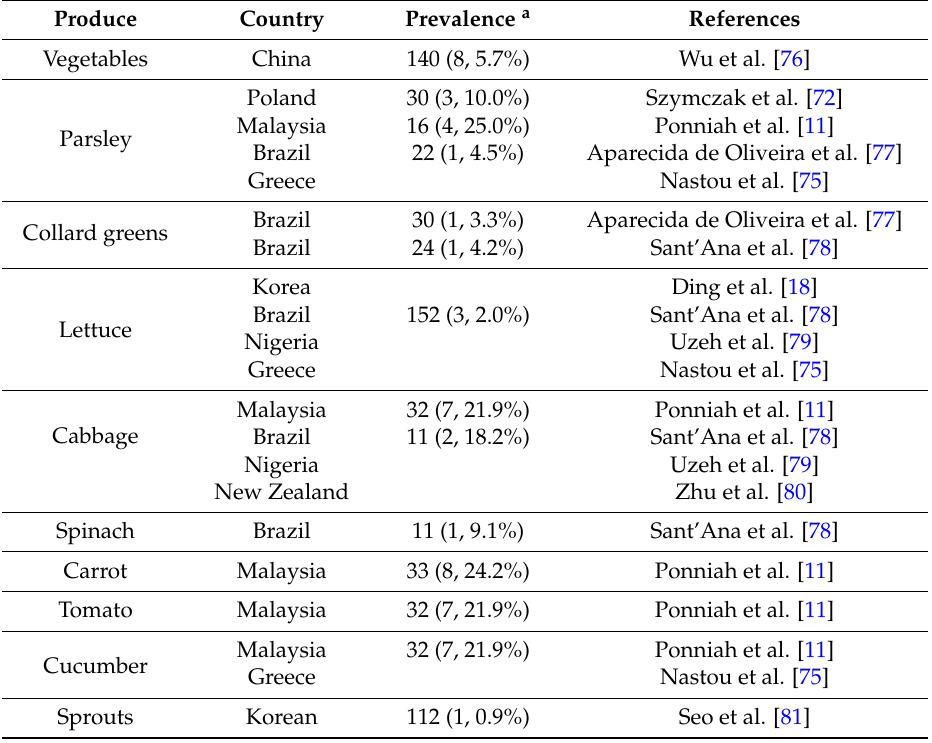
Table 3. Some selected studies that reported the prevalence of L. monocytogenes in fresh produce. Produce Country Prevalence